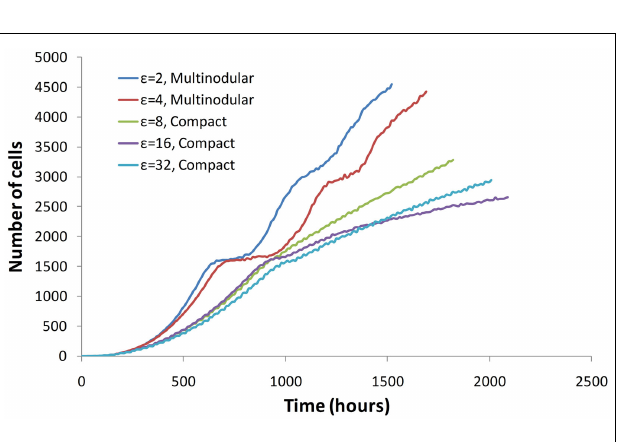
FIGURE 4 |The growth rate of a tumor depends on the properties of cancer cells and on tumor morphology. Initially all tumors grow exponentially and with time their growth plateaus. However, multinodular tumors can initiate new phases of growth at a linear rate.